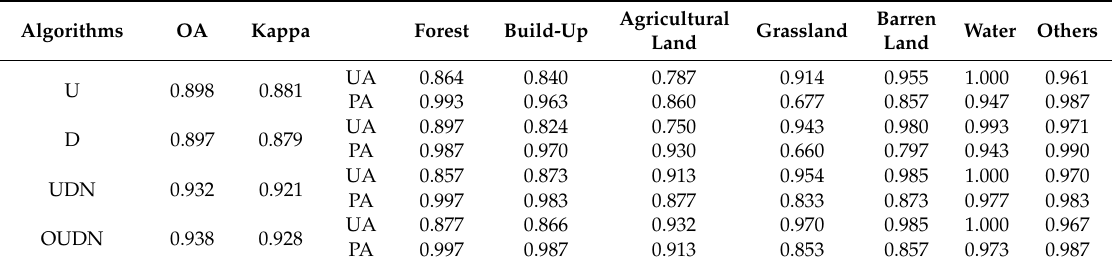
Table 6. The classification accuracies of the U, D, UDN, and OUDN algorithms based on the Spe-Texture, including the accuracies (UA and PA) of every class, OA and Kappa.